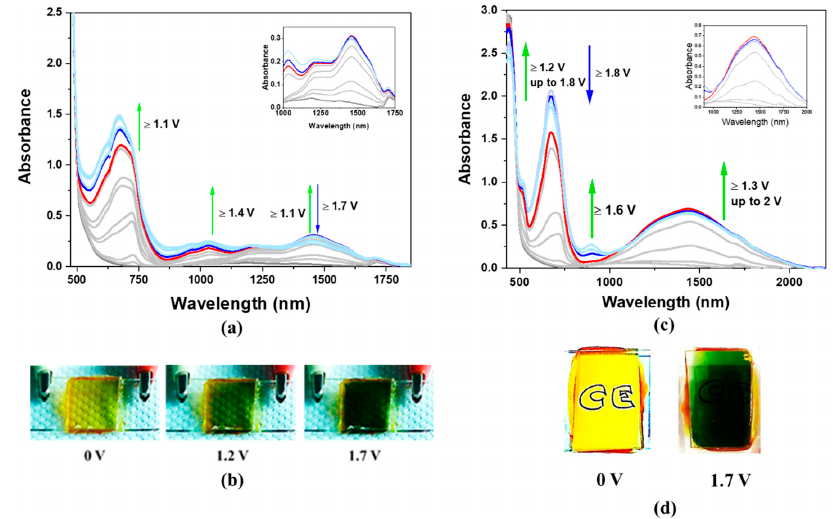
Figure 1. Spectroelectrochemistry of the ITO/EC/ITO device containing ( a ) the TV/Fc system and ( c ) the TV/FD as anode and cathode, respectively. Film thickness = 5 μ m. Color code according to the longer-wavelength NIR band. Gray lines: spectral growth as a function of the potential up to 2 V bias, where the maximum absorption in the NIR band at 1450 nm is observed (red line); from blue to light blue lines: bleaching of the NIR band at 1450 nm above 2 V. Photographs of ( b ) the TV/Fc device in the off state (0 V), and in the intermediate (1.2 V) and fully colored states (1.7 V) and of ( d ) the TV/FD device at 0 V and 1.7 V.